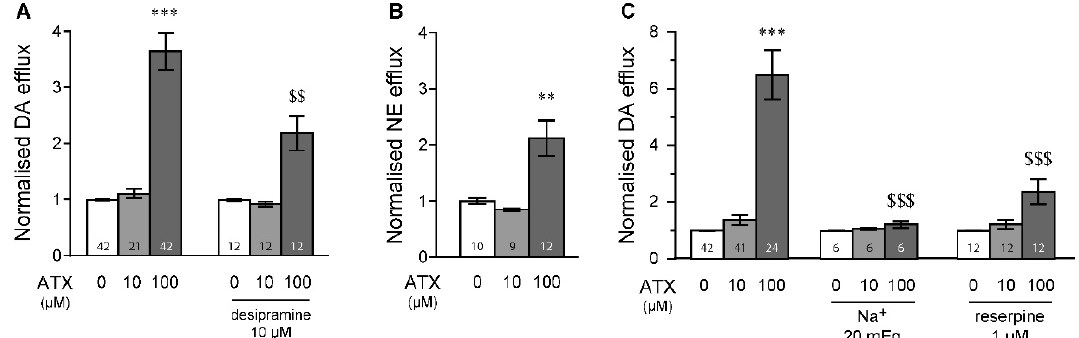
Figure 5. ATX modulates neurotransmitter efflux in the PFC and striatum. ( A ) Application of 100 µM of ATX significantly induced dopamine efflux in the PFC, which was significantly reduced when the norepinephrine transporter inhibitor desipramine (10 µM) was applied as a pre-treatment. Bonferroni post hoc tests after significant two-way ANOVAs. ( B ) ATX at 100 µM also induced significant norepinephrine efflux in the PFC. ( C ) Striatal dopamine efflux induced by ATX under baseline, low-Na + buffer and pre-treatment with reserpine. n values are given for each condition and represent number of tissue samples used. Please refer to Supplementary Table S1 for statistical results. *** p < 0.001, ** p < 0.01 vs . 0 µM. $$$ p < 0.001, $$ p < 0.01 vs . 100 µM in control.